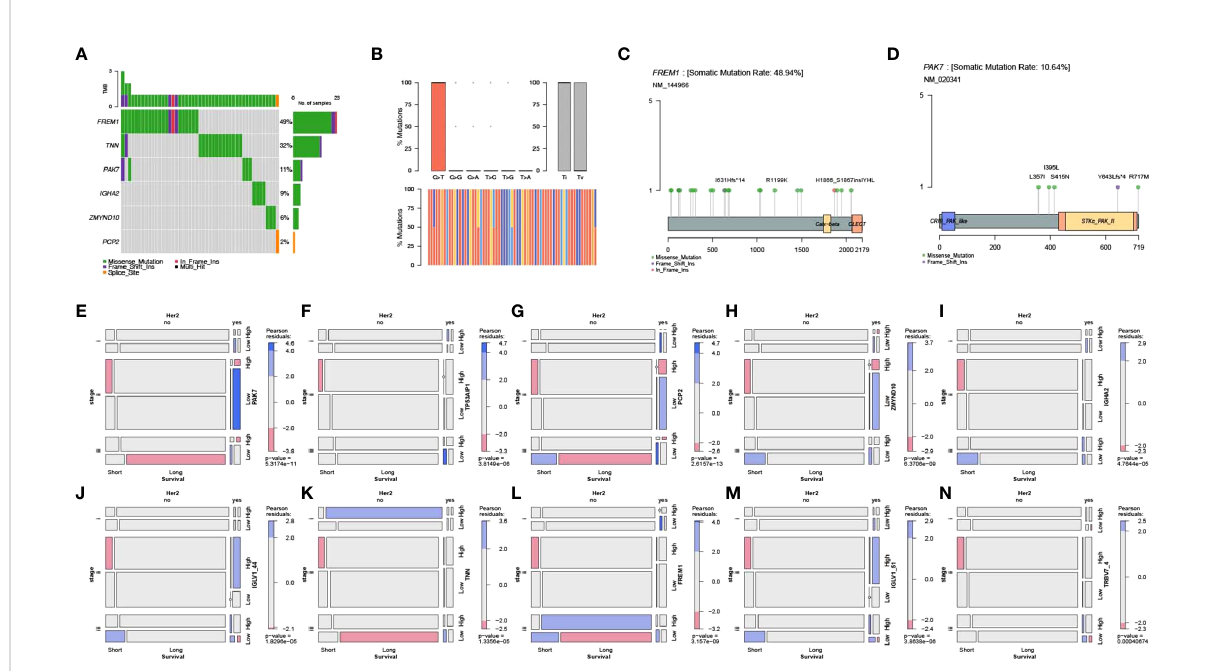
FIGURE 7 Mutation analysis of key genes and their correlation with clinical features. (A) Waterfall plot for point mutation analysis of key pyroptosis factors in samples from the TCGA-BRCA dataset. (B) Statistical plot of point mutation types. (C, D) Point mutation distribution for FREM1 and PAK7 and (E – N) the relationship between key pyroptosis factors and TCGA molecular typing, Her2 status, and stage of breast